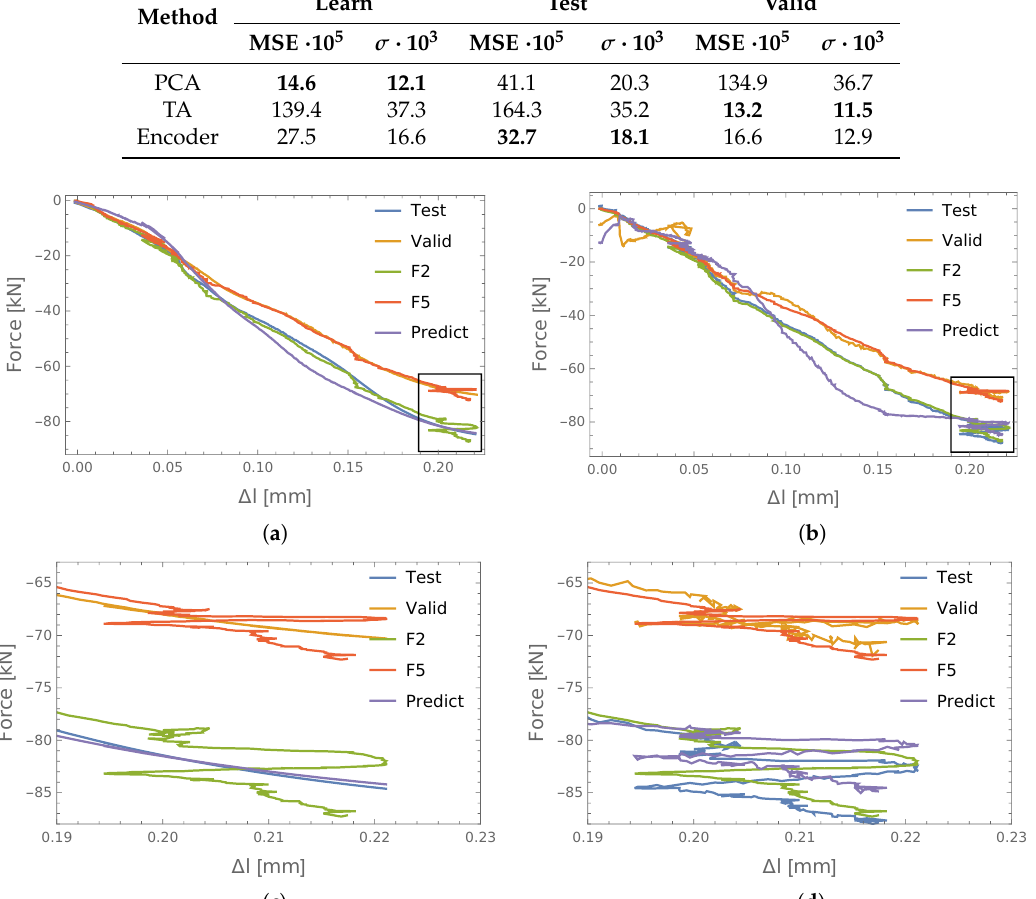
Figure 8. The results of identification forces: P1. ( a ) Encoder; ( b ) PCA; ( c ) details ( a ); ( d ) details of ( b